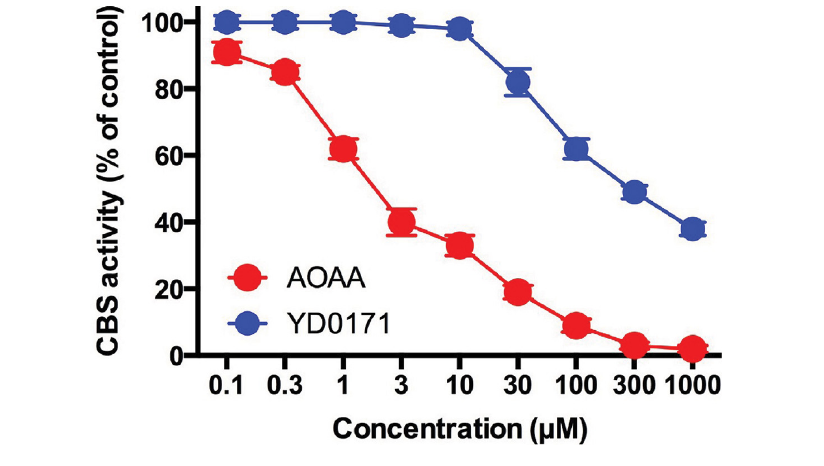
S-synthesizing activity of human 2 S 2 of ~2 μ mol/L, while YD0171 was 50 : ~300 μ mol/L). 50